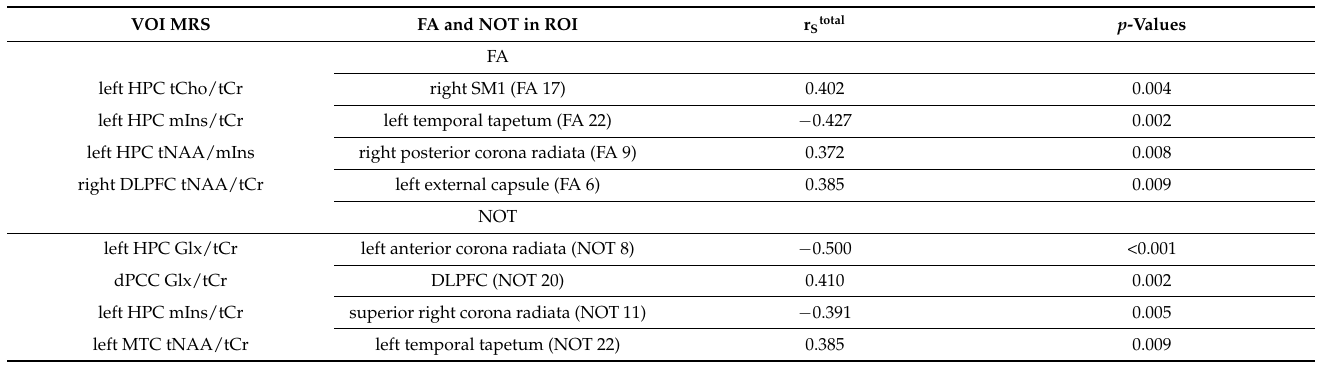
Table 7. Significant correlations between WM tractographic properties and 1 H-MRS neurometabolites for the total